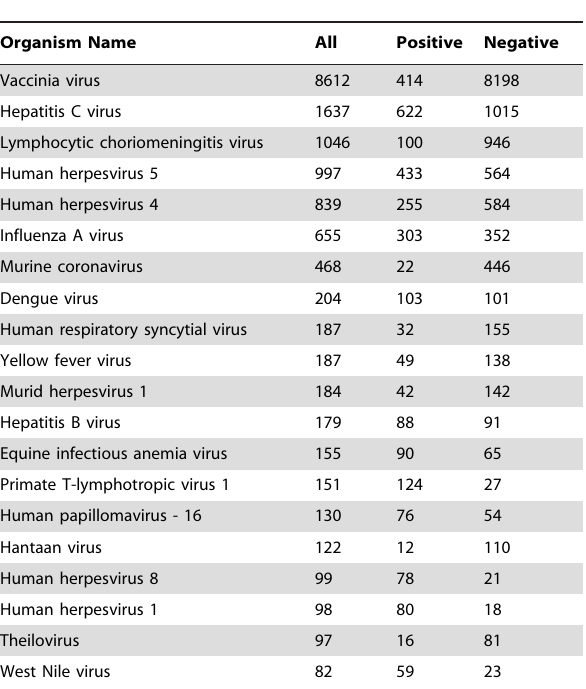
Table 1. MHC class I restricted T-cell epitopes retrieved from the Immune Epitope Database for viral